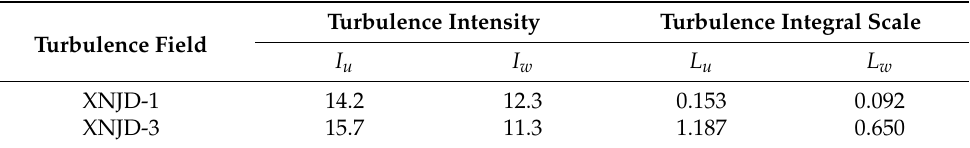
Table 1. Turbulence characteristics parameters.